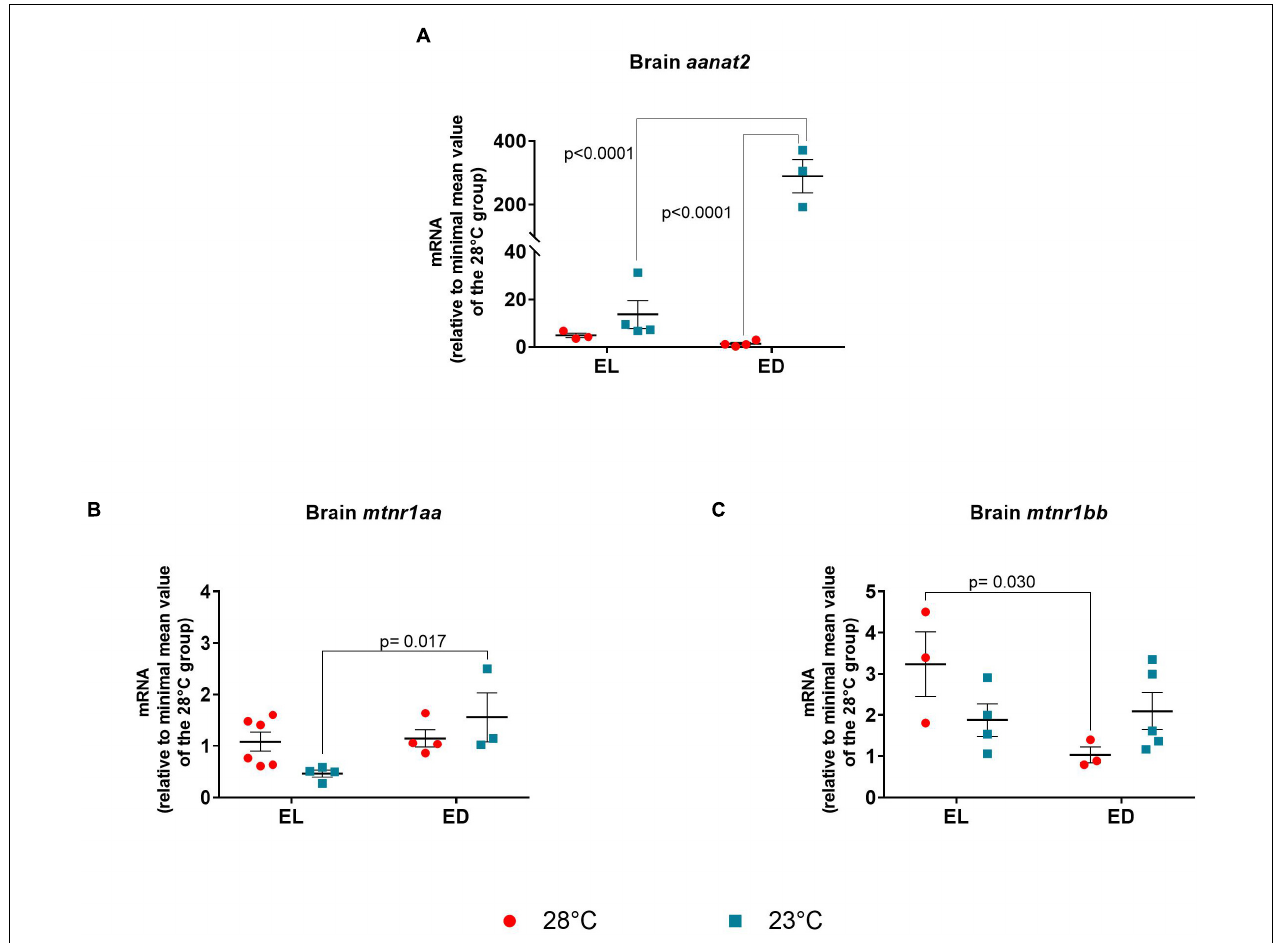
FIGURE 5 | Early light (EL) and early dark (ED) gene expression of arylalkylamine N -acetyltransferase ( aanat2 ) and melatonin receptors ( mtnr1aa and mtnr1bb ) in adult Danio rerio . (A) Brain aanat2 ; (B) Brain mtnr1aa ; (C) brain mtnr1bb. The gene expression was normalized by the 18S rRNA and expressed relative to the lowest mean of the control temperature group. The values are expressed as mean ± SEM. n = 3–6 (pools of four animals each). Significant differences are shown when p < 0.05. Red symbol corresponds to 28 o C and blue symbol corresponds to 23 o